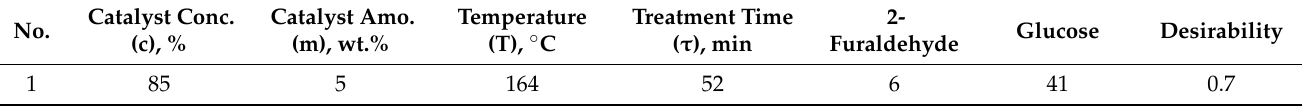
Table 7. Obtained optimal process